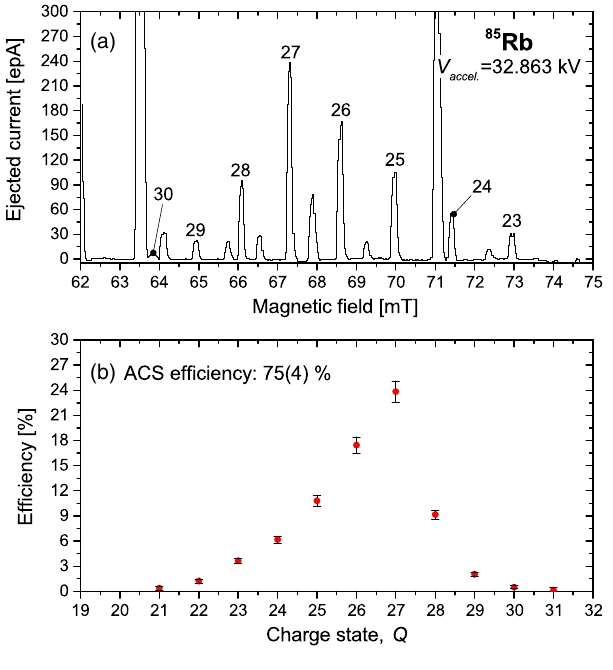
FIG. 7. Same as Fig. 6. but for 85 Rb. calculated by summing the SCS efficiencies shown in each figure. All charge states outside the range of the Q=A scans were considered negligible. The uncertainty of the SCS efficiencies results primarily from the (cid:2) 2 -pA error asso- ciated to the noise of the Faraday cups and ammeters. The uncertainty of the ACS efficiencies was obtained from